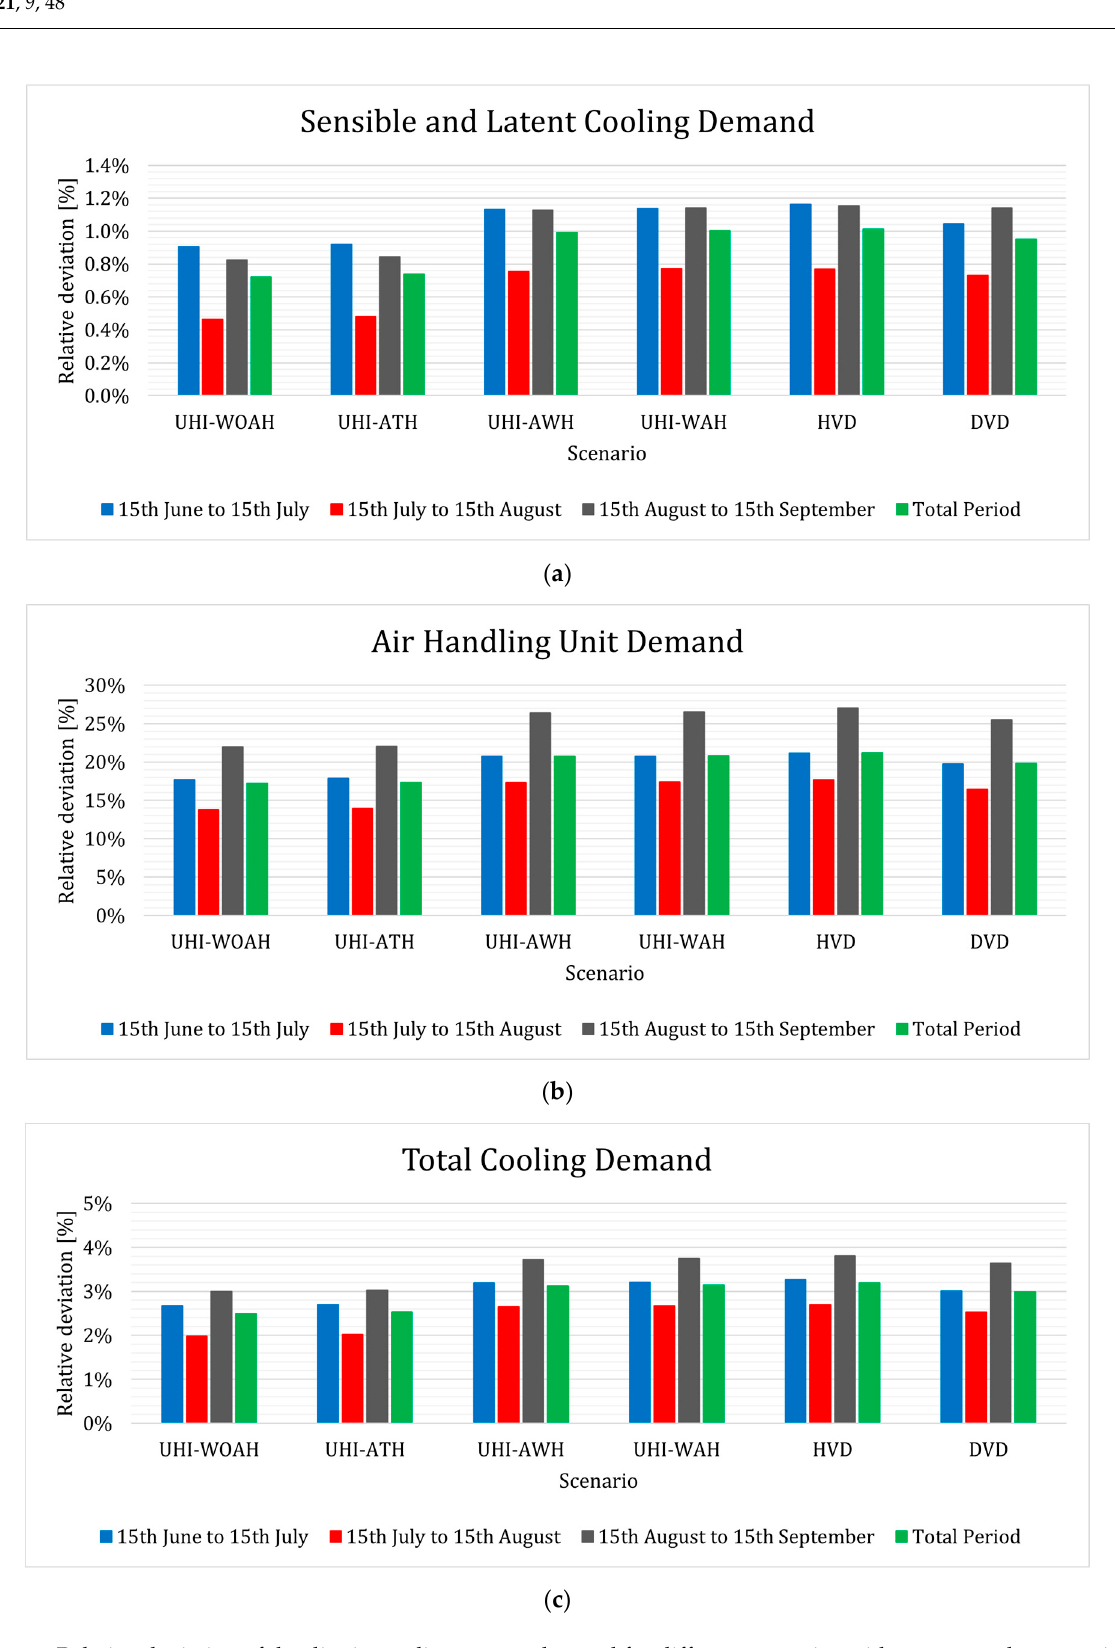
Figure 9. Relative deviation of the district cooling energy demand for different scenarios with respect to the case without considering the urban heat island effect.